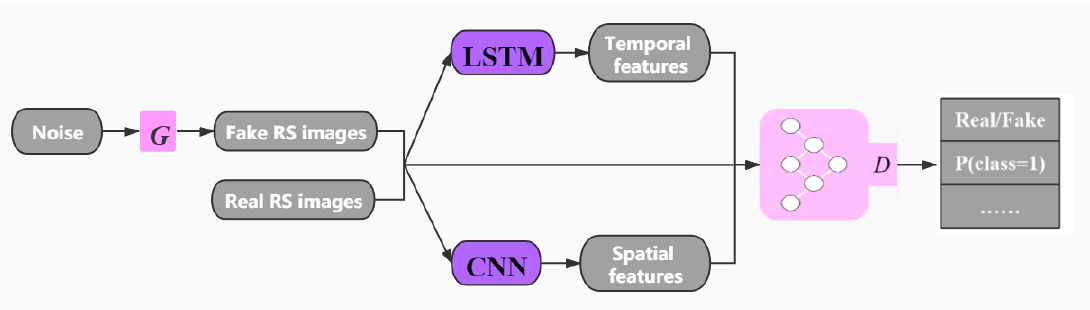
Figure 6. Overall model architecture.